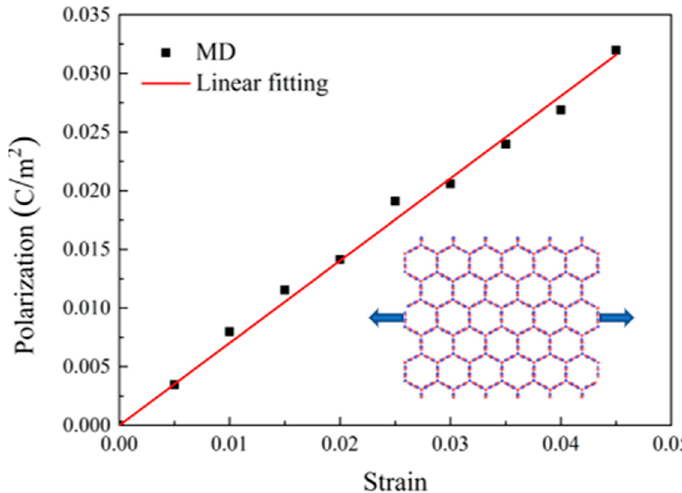
Figure 10. The polarization-strain curves of BNHCs under tensile loading along the zigzag direction obtained from MD simulations.